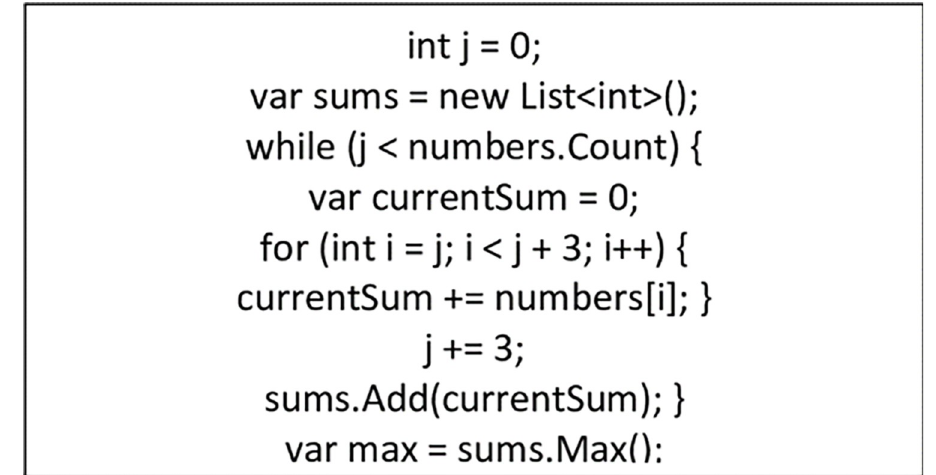
Fig 8. Applying SWA to generate maximum sum in c#.